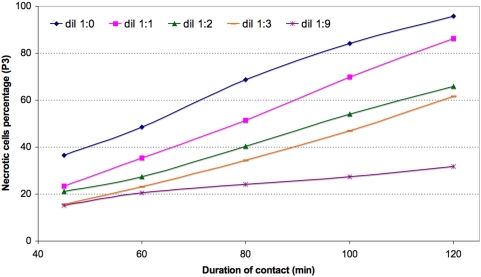
Kinetics of mouse splenocyte necrosis induction by decreasing concentrations of a stock non-cytosolic fraction titrating 8 108 trypanosome equivalents per ml.